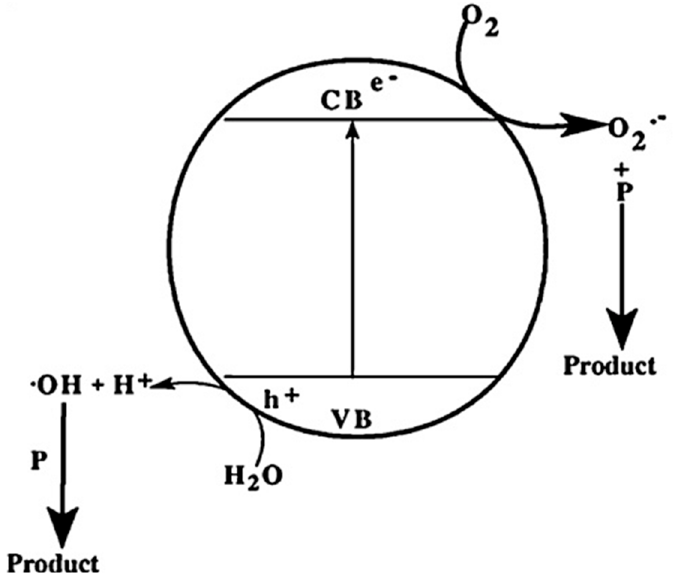
Figure 3. Simpli fi ed mechanism for the activation of a semiconductor by light. Adapted with Figure 3. Simplified mechanism for the activation of a semiconductor by light. Adapted with permission from [61] . Copyright © 2010 Elsevier. permission from [61]. Copyright © 2010 Elsevier.